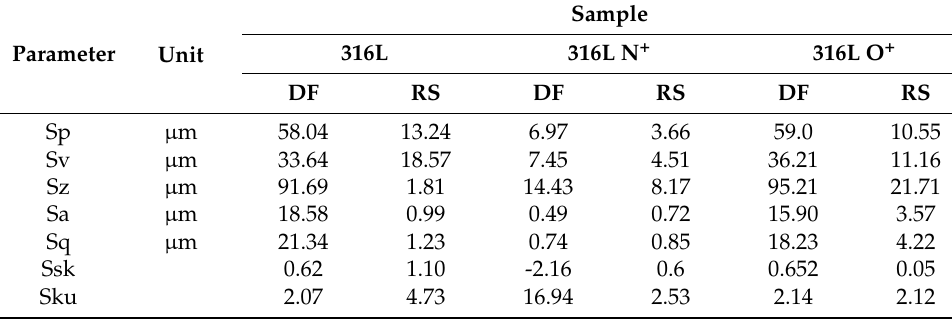
Figure 19. Optical and axonometric views of ball wear track and the wear profile on transverse cross-section after the RS-lubricated sliding of the oxygen ion-implanted steel 316L—Al 2 O 3 friction pair. Table 6. Amplitude parameters of wear tracks.